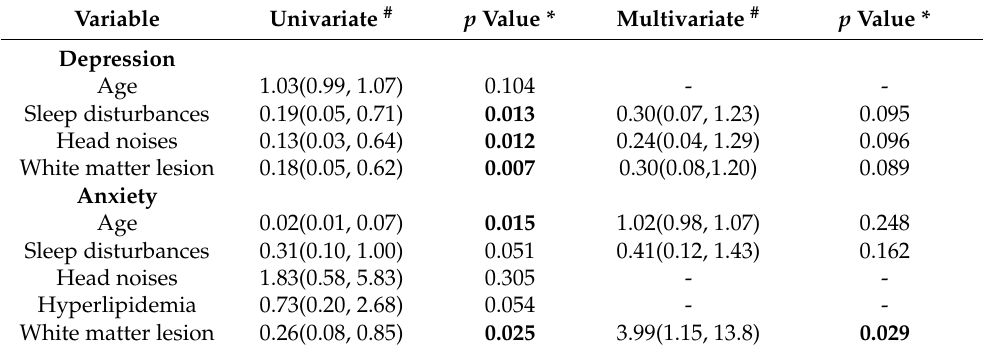
Table 3. Univariate and Multivariate logistic regression analysis between depression and risk factors.